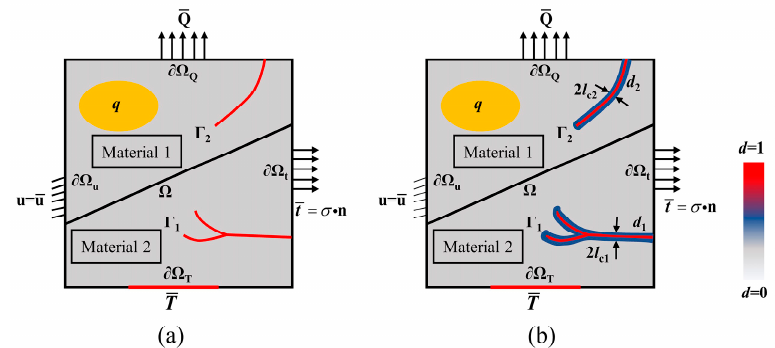
Figure 2. Diagram of the multiphase thermo-mechanical coupling phase-field fracture of an elastic solid. ( a ) Solid embedded sharp crack/interface geometry, ( b ) Phase field regularized crack/interface geometry